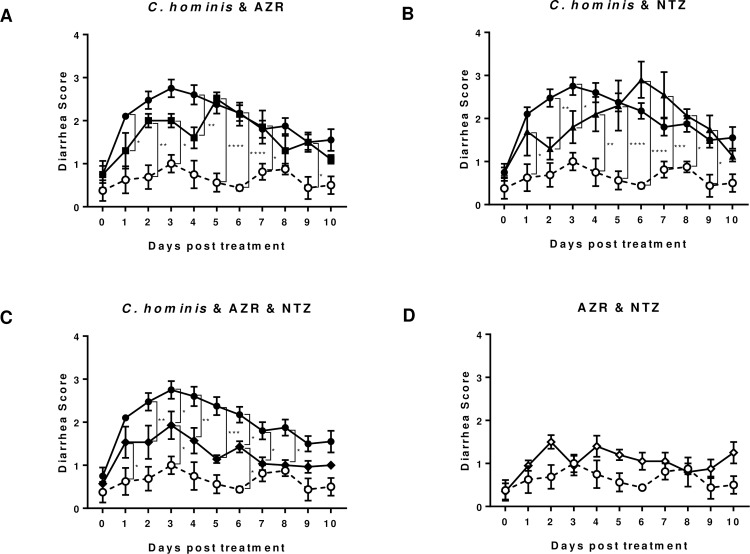
Daily diarrhea scores observed in piglets treated with either AZR (A), NTZ (B) or AZR+NTZ (C), compared with uninfected AZR+NTZ-treated and untreated groups (D). Two-way ANOVA with Tukey's multiple comparisons test was conducted using GraphPad Prism 7.01. *p<0.05, **p<0.01, ***p<0.001, ****p<0.0001. TU502-infected group (n = 10, closed circle ●) was compared with AZR-treated group (n = 5, closed squire ■) in A; with NTZ-treated group (n = 5, closed triangle ▲) in B; and with AZR+NTZ-treated group (n = 7, closed rhombus ◆) in C; Uninfected group treated with AZR+NTZ (n = 5, open rhombus ◇) and untreated control group (n = 4, open circle ○) are presented in D.